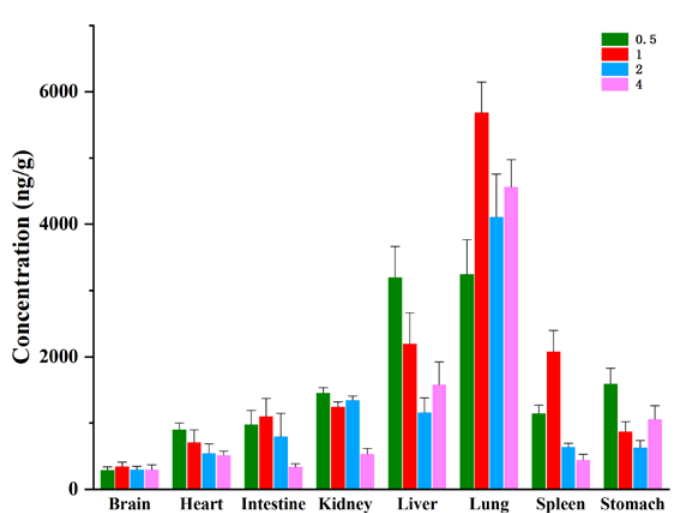
Figure 4. The mean concentration of alnustone in different tissues (ng/g) at 0.5, 1, 2 and 4 h after an intravenous administration of 5 mg/kg alnustone to the rats (Mean ± SD, n = 5). The tissue distribution characteristics of alnustone were determined at 4 h after i.v.